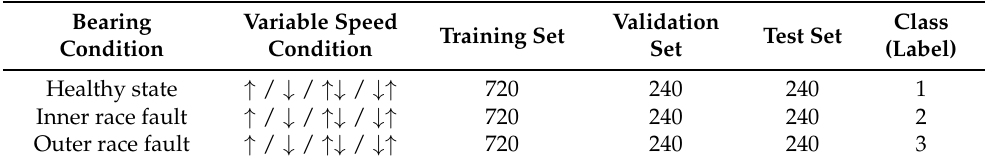
Table 1. Bearing dataset of the University of